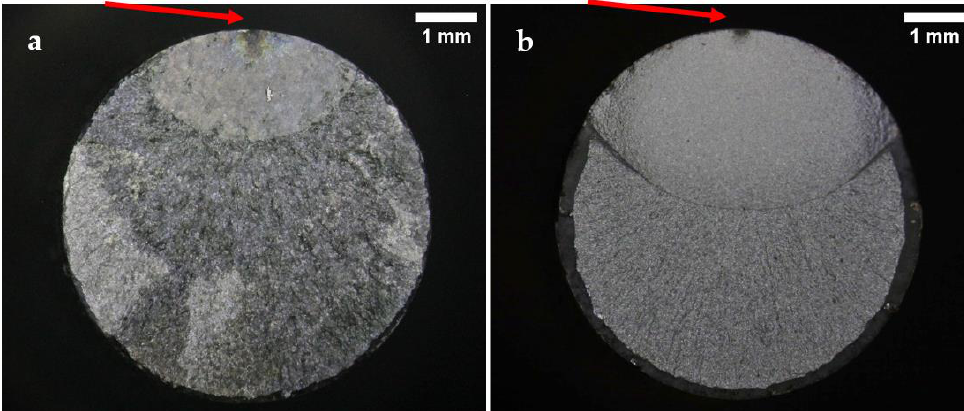
Figure 9. Fracture surfaces after fatigue tests of ( a ) A-type and ( b ) B-type H13 steels, tested in a corrosive medium to a maximum stress of 750 MPa (52% and 51% YS, respectively).